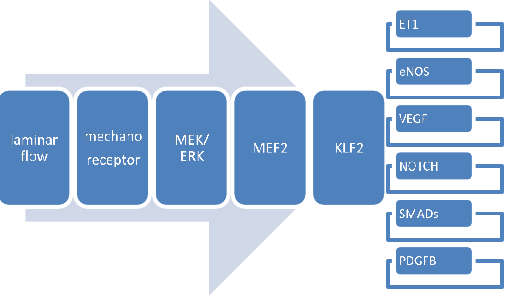
Figure 5. Alteration in laminar flow invokes changes in mechanoreceptors such as monocilia